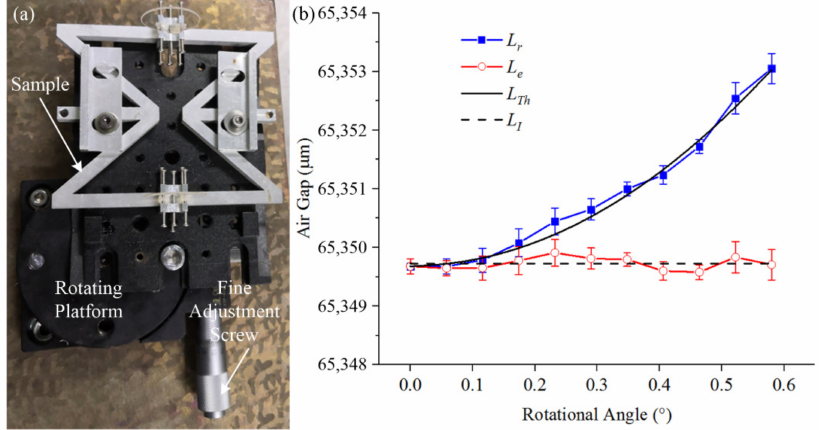
Figure 8. Measurement results after artificial additional rotation. ( a ) The experimental device of the sample rotation. ( b ) Measurement results after rotation. “ L r ” is the measurement length of the air gap after rotation. “ L Th ” is the theoretical length of the air gap after rotation. “ L e ” is length of the air gap after elimination of the measurement error of rotation. The dashed line is the initial length of the air gap before